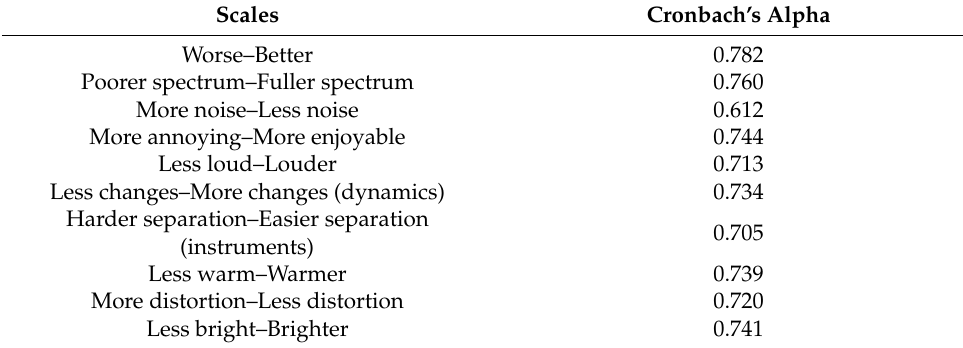
Table 4. Reliability of the ten bipolar